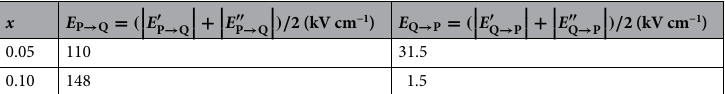
Table 1. Threshold fields of the E -induced phase transition between the AFE-P and the FE-Q phases estimated from the J – E loops (Fig. 5).